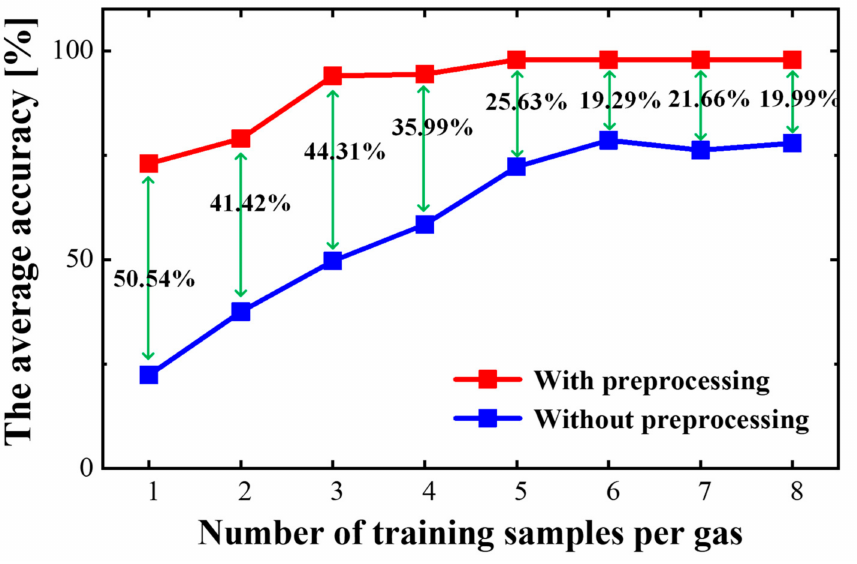
Figure 4. The average accuracy for all 9 types of gas with different numbers of training samples for each gas.